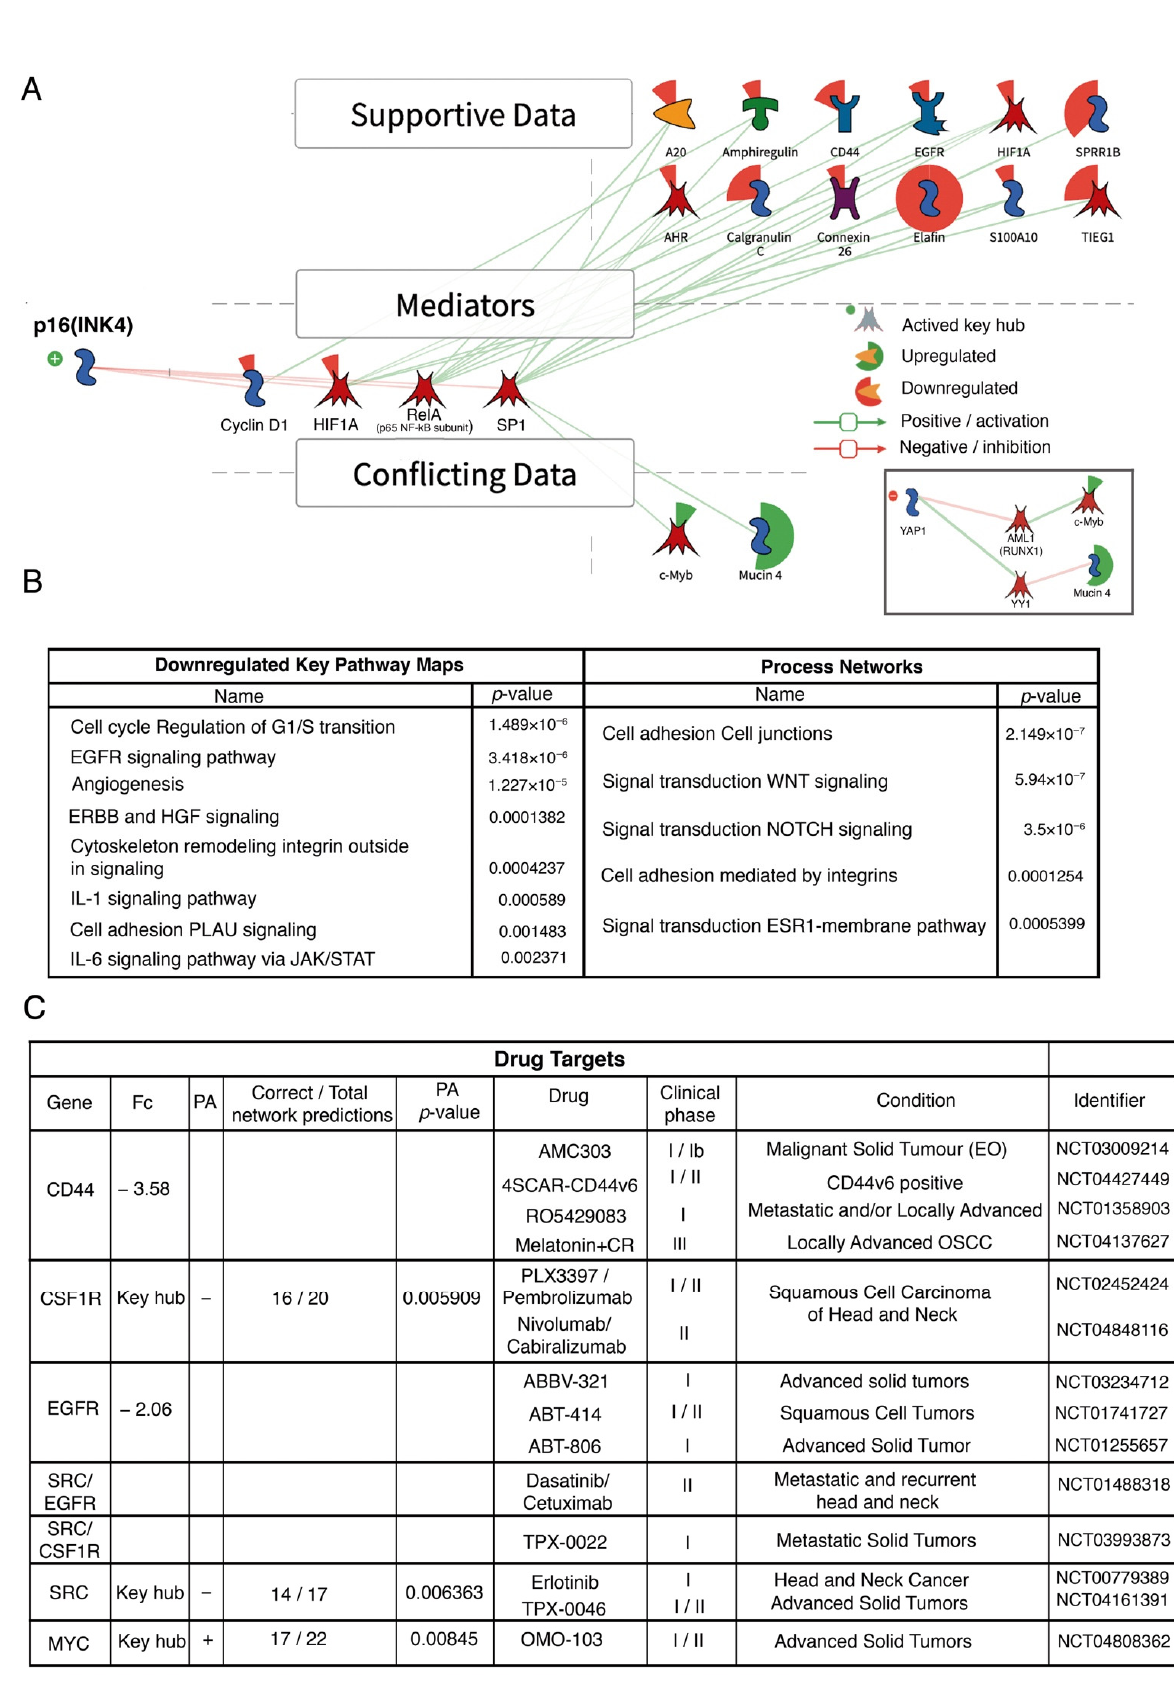
Figure 6. Integration map, signaling pathways, and molecular processes enriched in HPV+ HNSCC patients. ( A ) Diagram- matic summary suggesting p16 activation as a “master” regulator in HPV − positive patients. As shown, p16